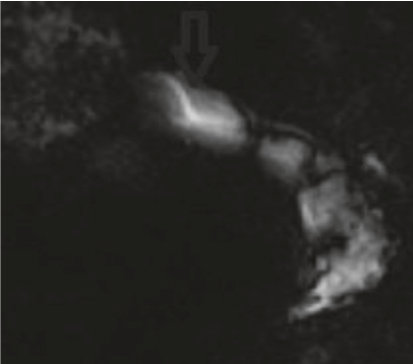
Figure 4: Microscopic examination of the tubular structure confirming a thick mucus content and absence of parasitic